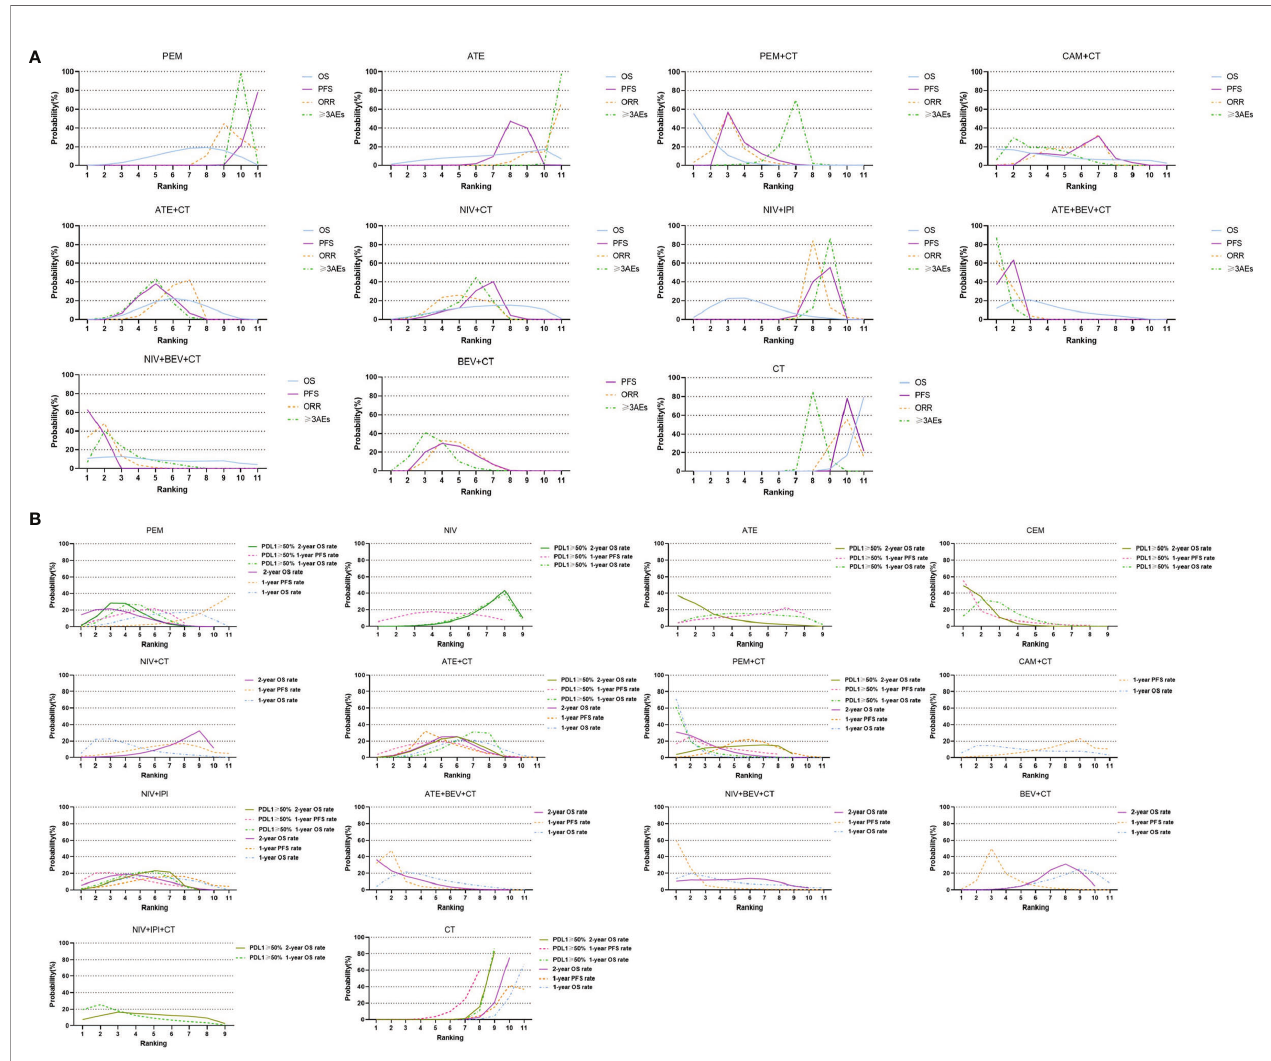
FIGURE 4 | Bayesian ranking pro fi les of comparable treatments with long-term survival on ef fi cacy and safety for patients with advanced NSCLC. (A) Pro fi les indicate the probability of each comparable treatment being ranked from fi rst to last on overall survival (OS), progression-free survival (PFS), objective response rate (ORR), and grade 3 or higher adverse events ( ≥ 3 AEs). (B) Pro fi les indicate the probability of each comparable treatment being ranked from fi rst to last on 1-year survival rate and 1-year PFS rate and 2-year survival rate in the overall population, and 1-year survival rate and 1-year PFS rate and 2-year survival rate in patients with high PD-L1 subgroups. PEM, pembrolizumab; ATE, atezolizumab; NIV, nivolumab; DUR, durvalumab; TRE, tremelimumab; IPI, ipilimumab; CAM, camrelizumab; CEM, cemiplimab; BEV, bevacizumab; CT,